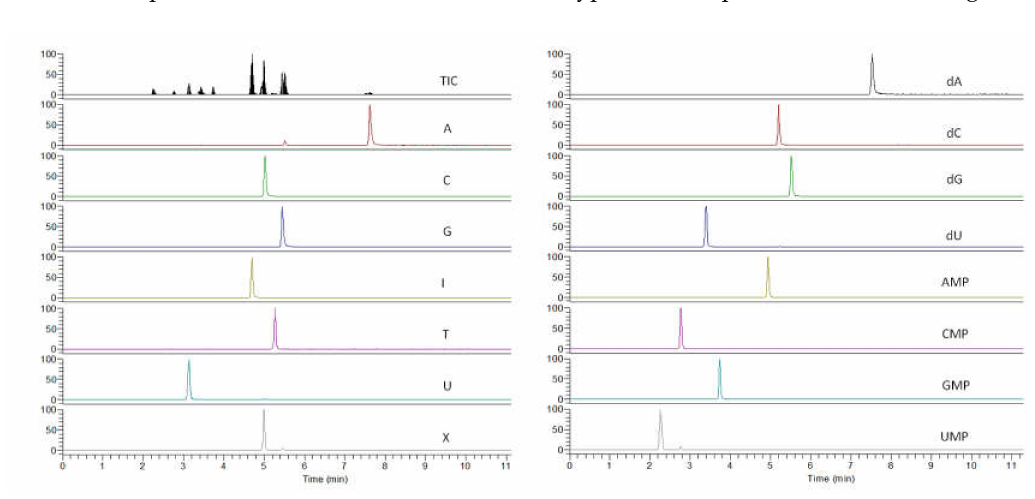
Figure 2. Ultra-performance liquid chromatography mass spectrometer chromatograms of 15 nucleic acid